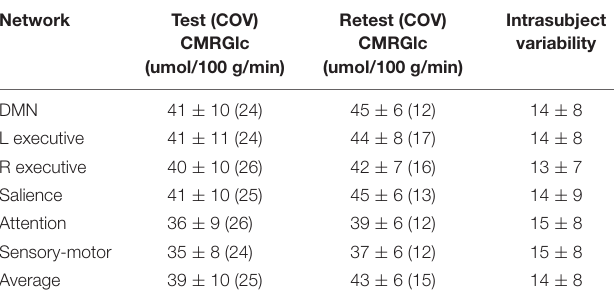
TABLE 1 | CMRGlc values determined for the test (Test) and retest (Retest) condition in each of the six major brain